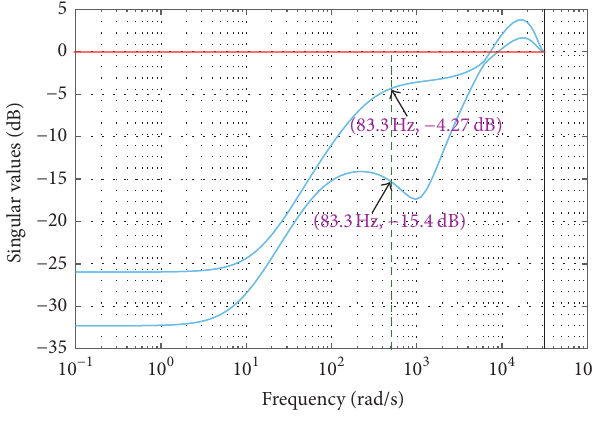
Figure 9: Singular values of the stability matrix.